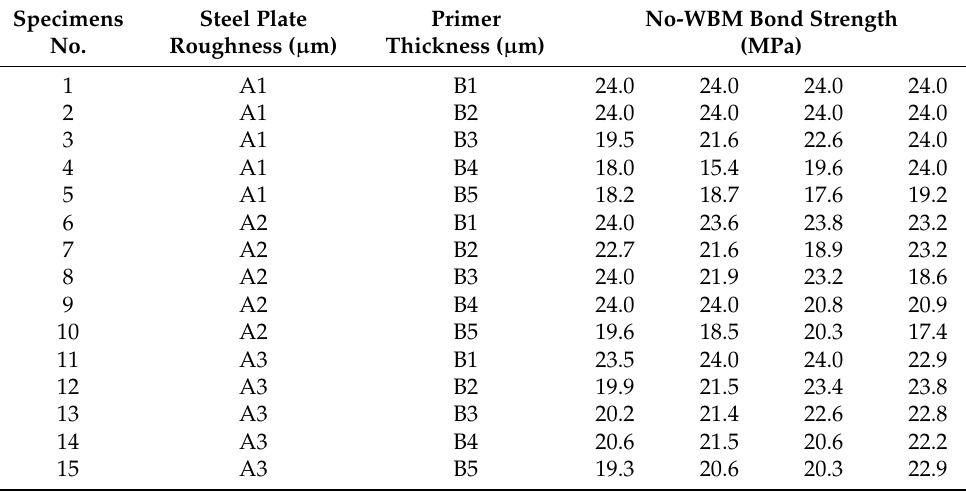
Table 11. Bond strength of the no-WBM